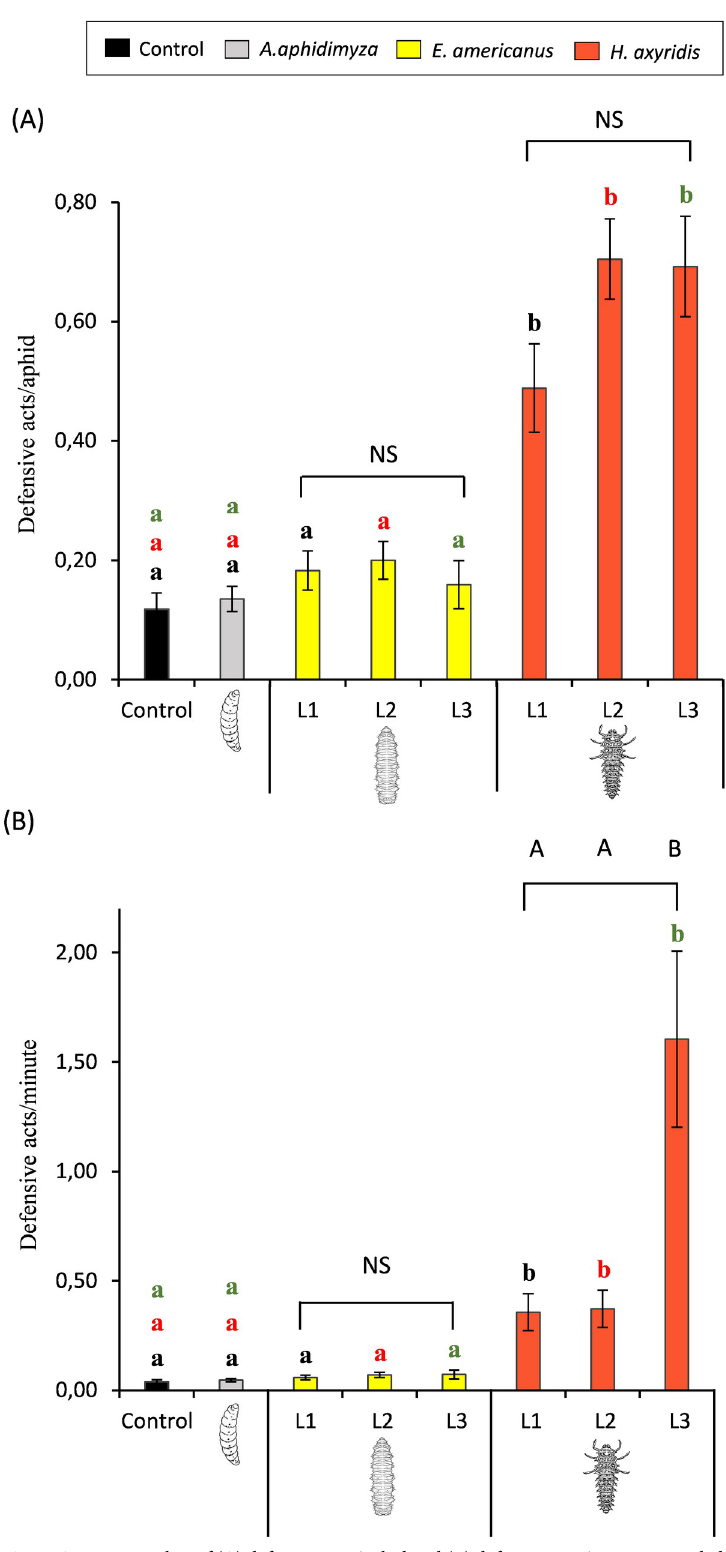
Fig 2. Average number of (A) defensive acts/aphid and (B) defensive acts/minute recorded for each treatment. Comparisons have been made between similar body-sized instars (small instars: black letters; medium instars: